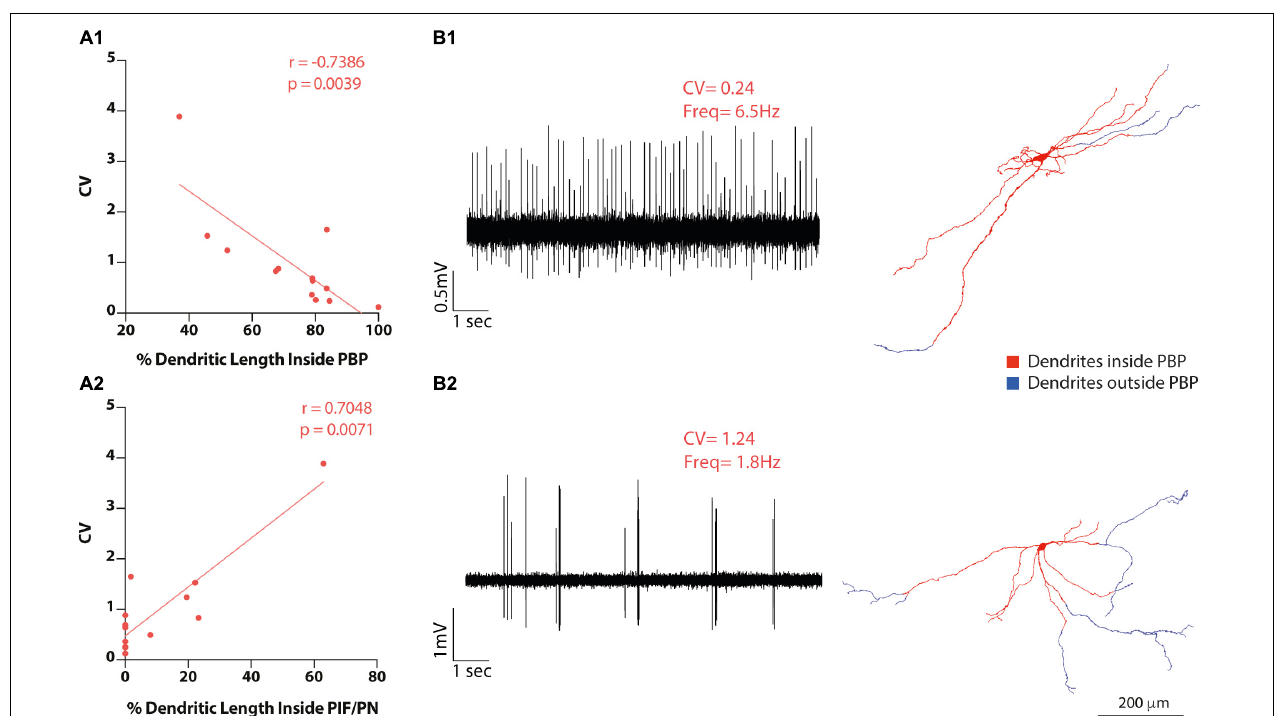
FIGURE 7 | VTA DA neuron heterotopic distribution of dendrites correlates with baseline electrophysiological activity. (A1-2) Firing regularity (CV) correlations with the proportion of dendritic length inside PBP (A1) or inside PIF/PN subdivisions. (B1-2) Raw data examples of firing traces of VTA DA neurons and their matching 3D reconstructions. Examples of one [ (B1) -top] regular and one [ (B2) -bottom] irregular VTA DA neuron raw baseline recordings (10 s) with their respective dendritic reconstructions [ (B1,B2) , right] showing dendrites inside PBP in red and their dendrites outside PBP in blue. Neuron in B2 is also shown in Figure 3 . Scale bar = 200 µ